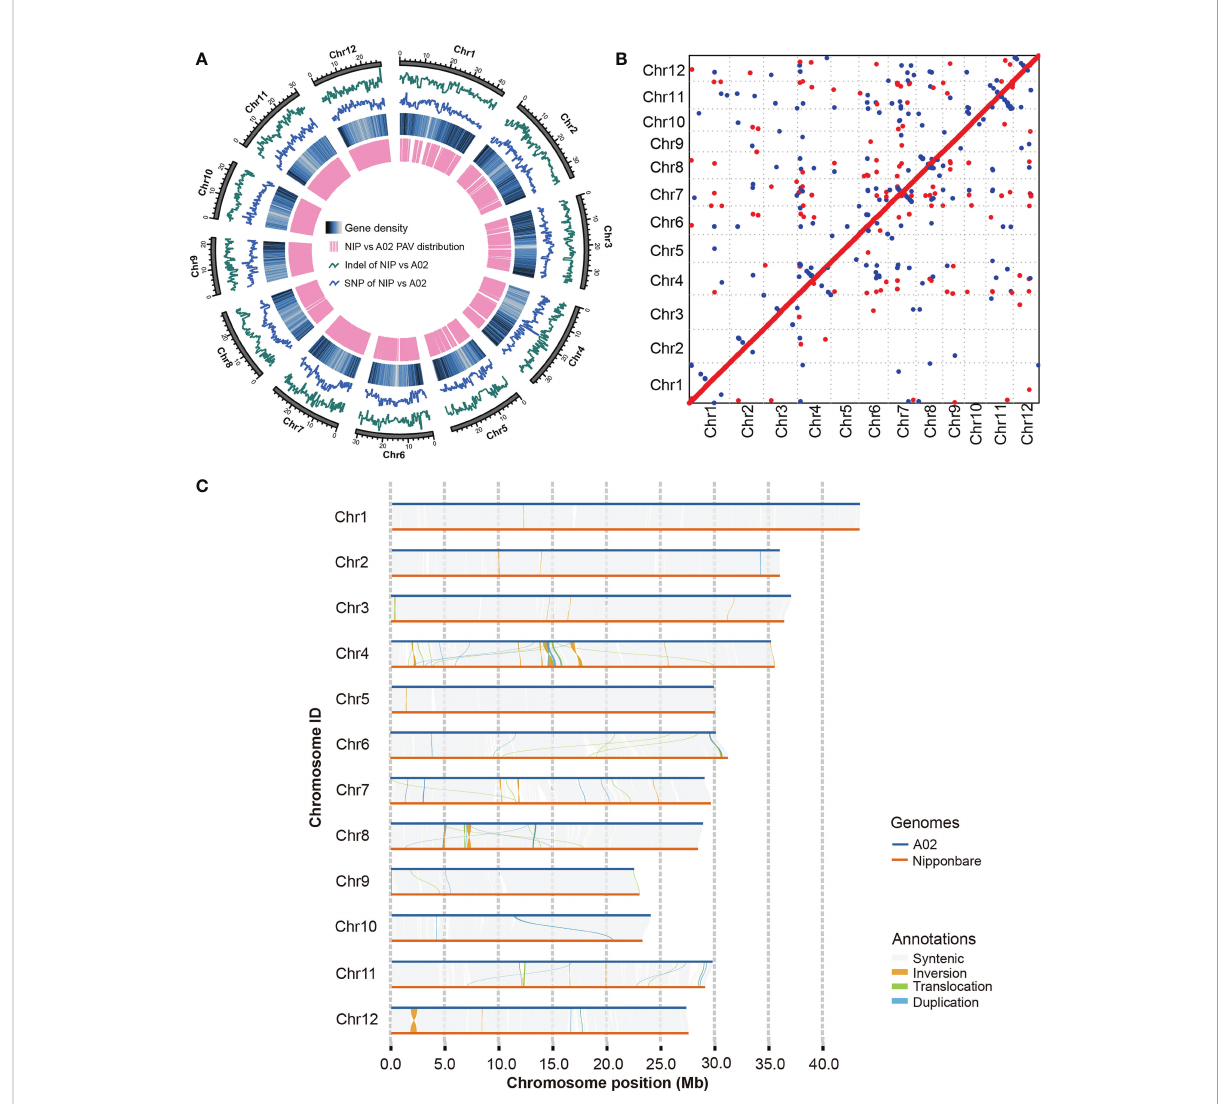
FIGURE 1 Assembly and analysis of A02 genome. (A) Landscape of A02 reference genome. Tracks from the outer to inner circles indicate: 1, indels between A02 and the Nipponbare reference genome; 2, SNPs in A02 with respect to Nipponbare; 3, gene density; 4, highlights of the PAV distribution between A02 and Nipponbare. NIP refers to Nipponbare. (B) The collinearity relationship between A02 genome and Nipponbare. The X-axis represents the genome of Nipponbare, and the Y-axis indicates the genome of weedy rice A02. (C) The collinearity of weedy rice A02 and